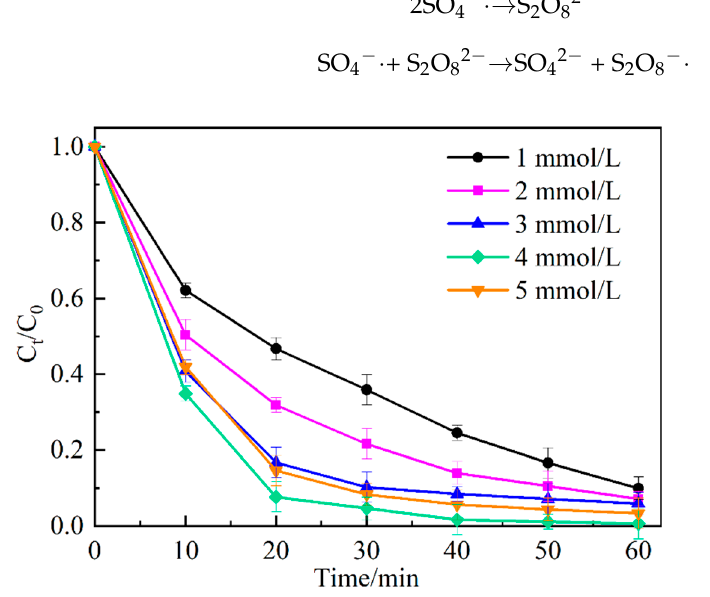
Figure 8. Effect of initial peroxydisulfate concentration on the degradation of MO.